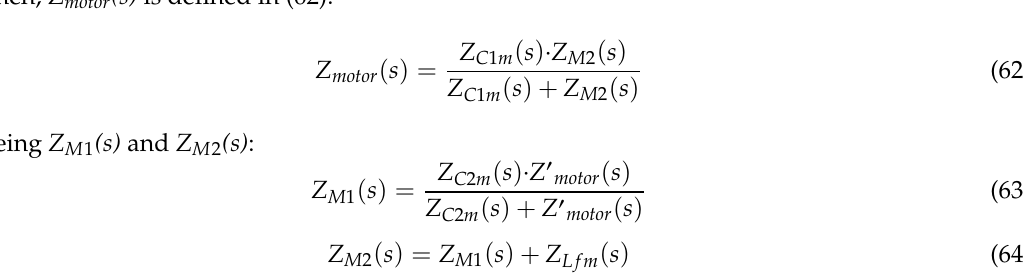
Figure 24. The input impedance of the motor drive-electric motor-vehicle system, including the input filter.